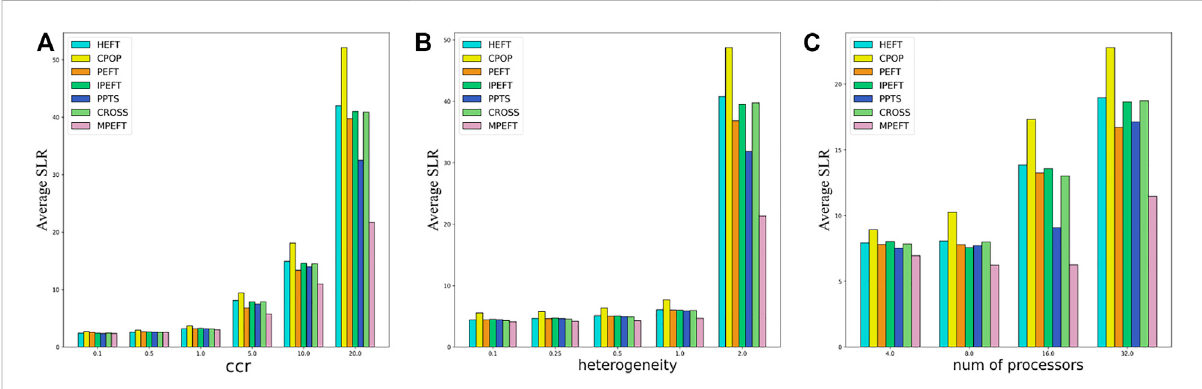
FIGURE 8 Average SLR as function of ccr (A) , heterogeneity (B) and number of processors (C) for Epigenomic Work fl ows.